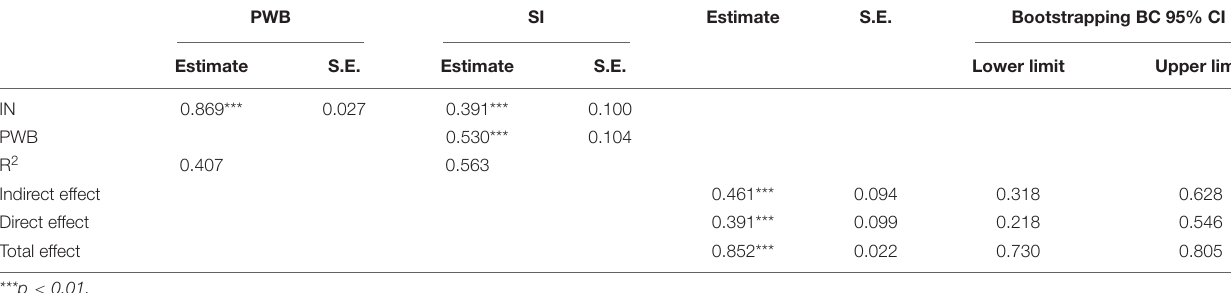
TABLE 6 | Mediating effect of social integration between intimacy and psychological well-being. PWB SI